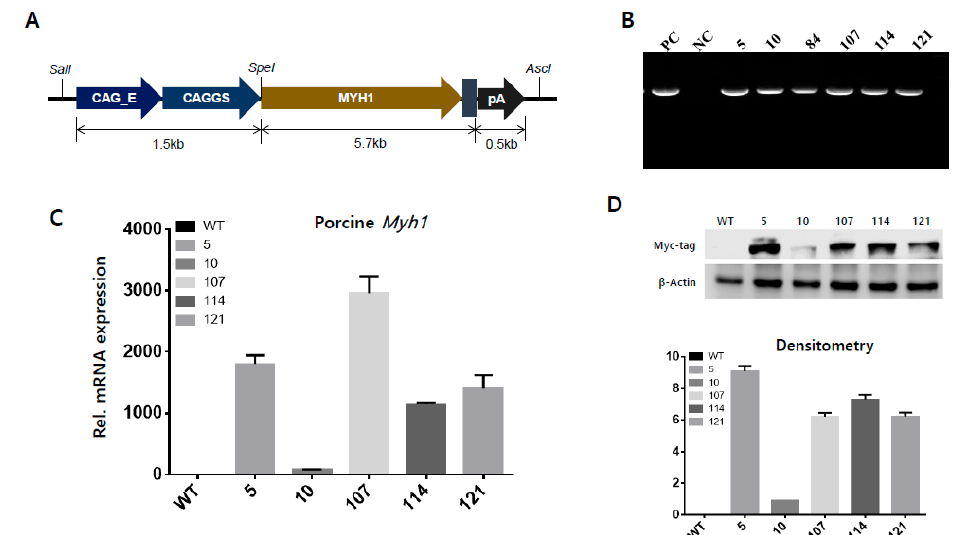
Figure 2. Development of porcine Myh1 gene transgenic mice and confirmation of expression patterns.